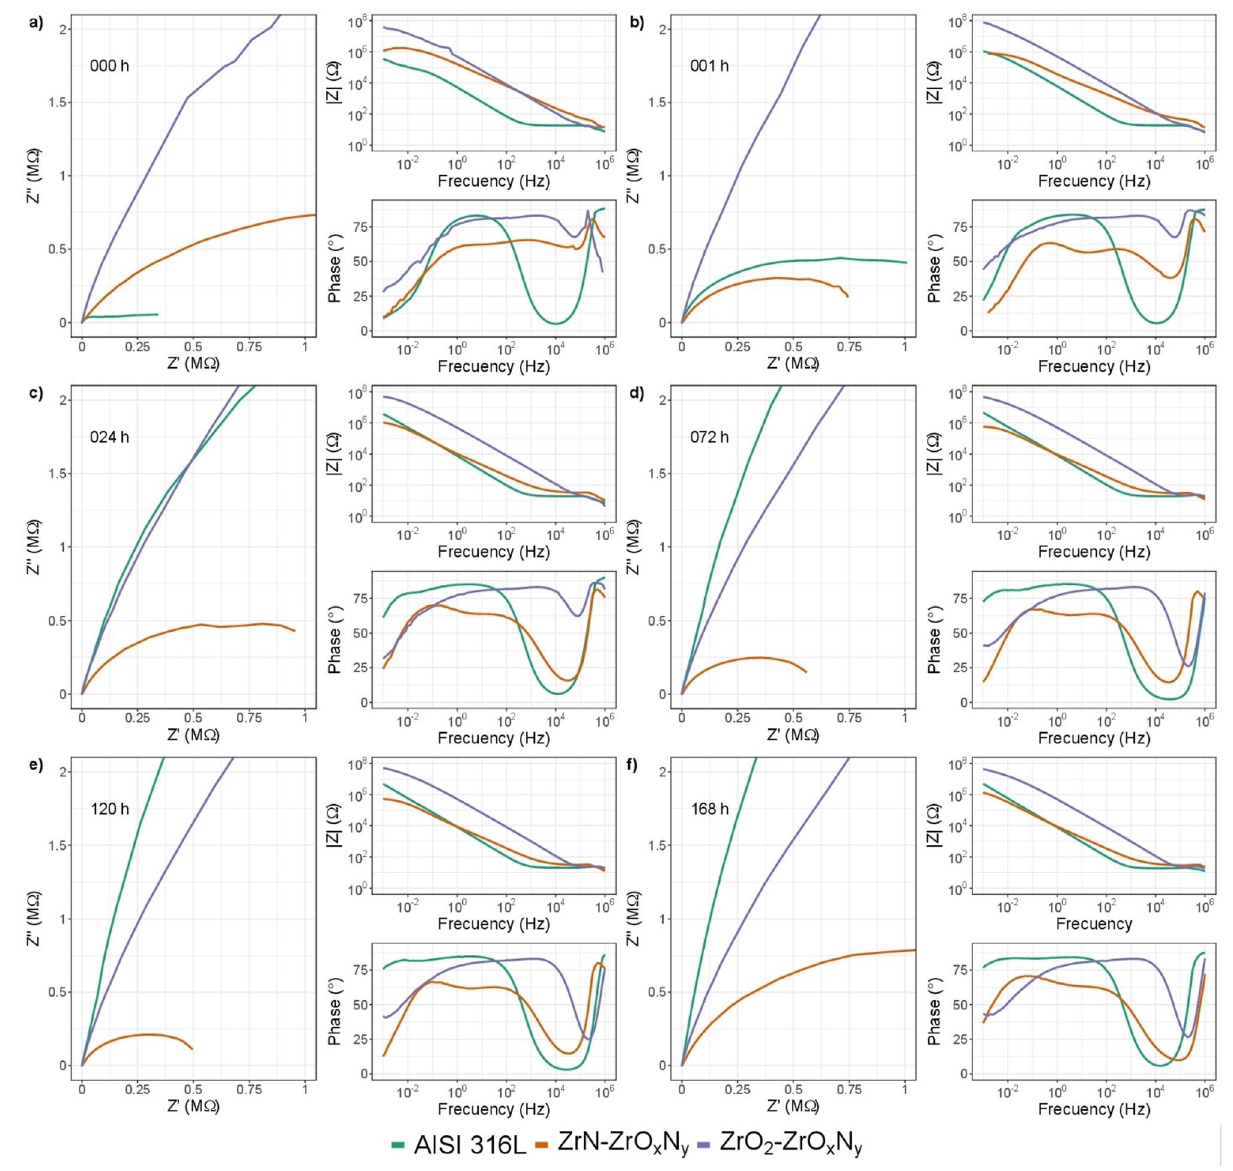
Figure 16. Comparative diagram for impedance modulus obtained after different immersion times in 3.5 wt. % NaCl solution for AISI 316L; for ZrN-ZrO x N y and for ZrO 2 -ZrO x N y